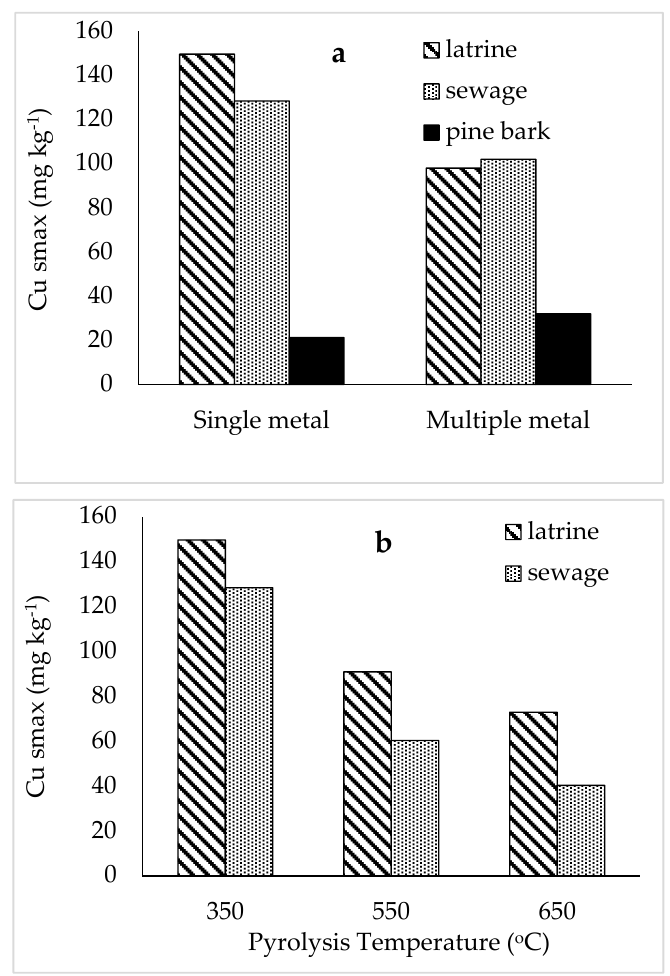
Figure 3. Sorption isotherms of copper from: ( a ) effluent on biochar pyrolysed at 350 °C, ( b ) single metal on biochar pyrolysed at 350 °C and ( c ) effluent on biochar pyrolysed at 550 and 650 °C. LW =